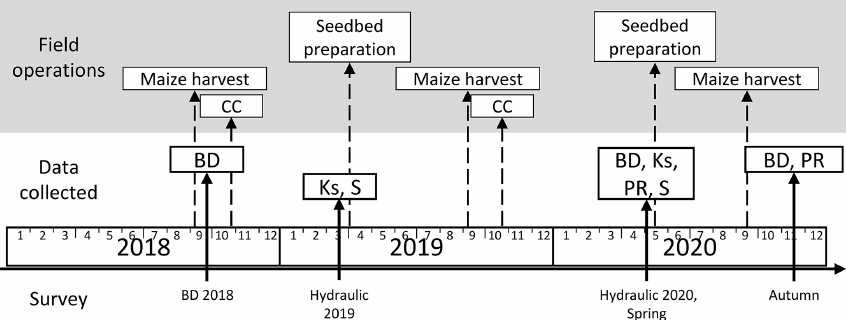
Figure 1. Survey timetable. Note: BD – bulk density; CC – cover crop seeding; Ks – saturated hydraulic conductivity; PR – penetration resistance; S – sorptivity. Table 1. Comparison of p values among the linear mixed-effect models analysis of bulk density (BD), penetration resistance (PR), saturated hydraulic conductivity (Ks), and sorptivity ( S ). Effects were considered significant if p ≤ 0 . 05. Note: GWC – gravimetric water content. BD PR Ks